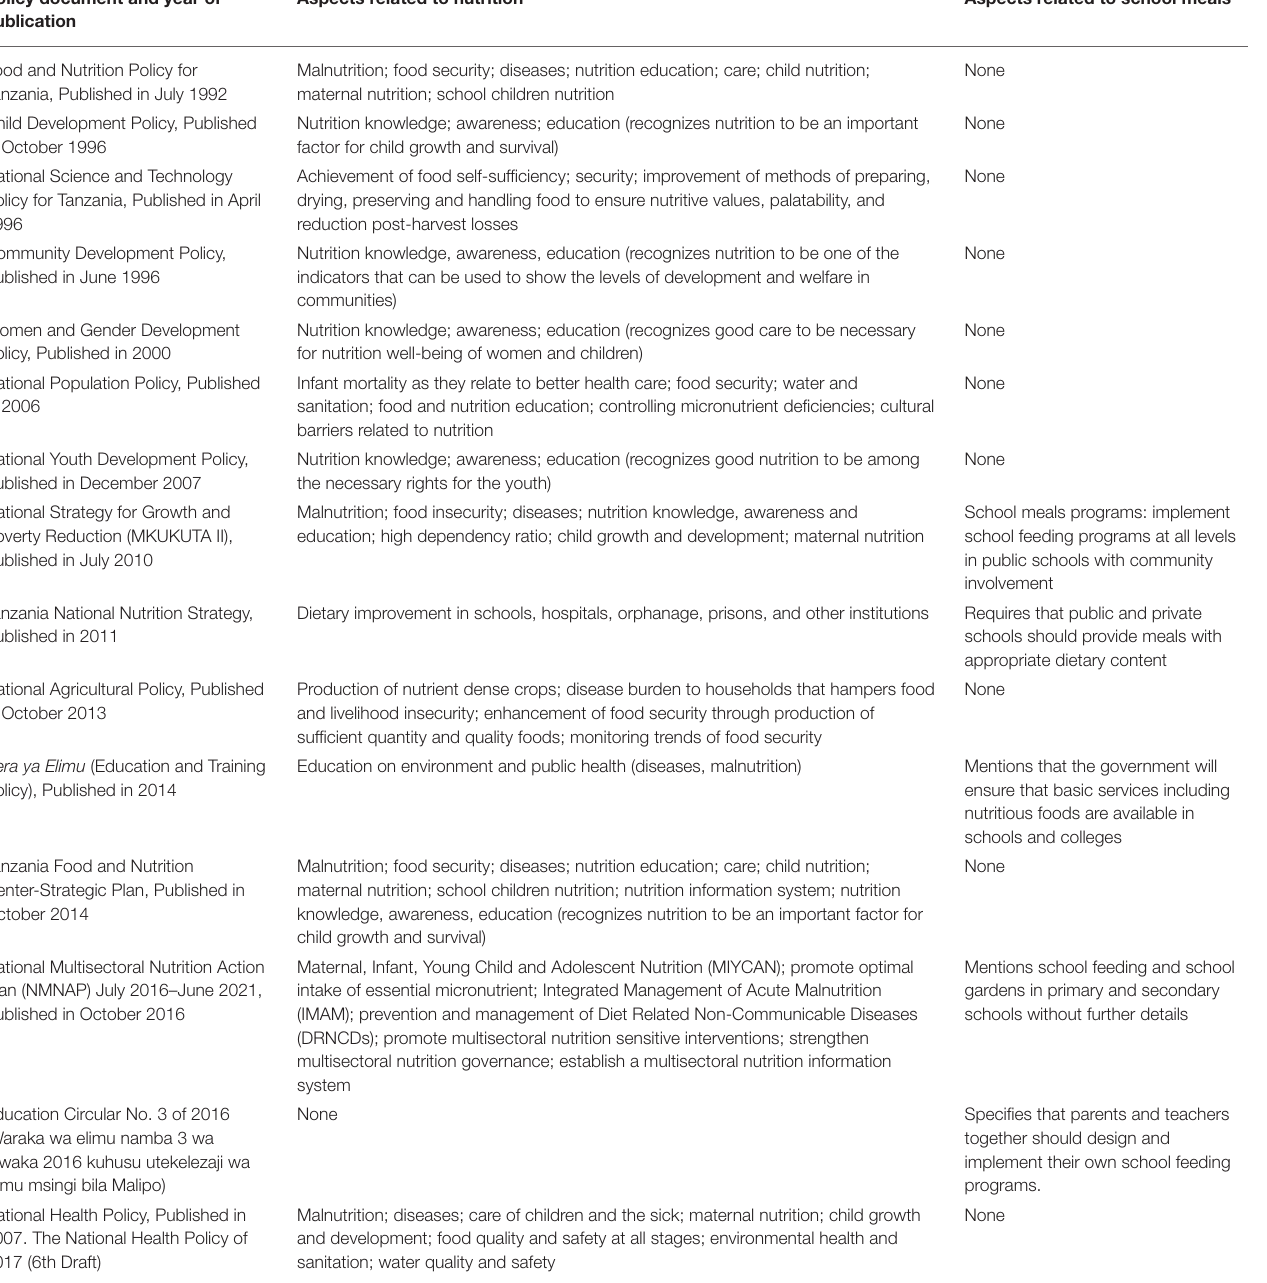
TABLE 1 | Policy content covered in relation to nutrition and school